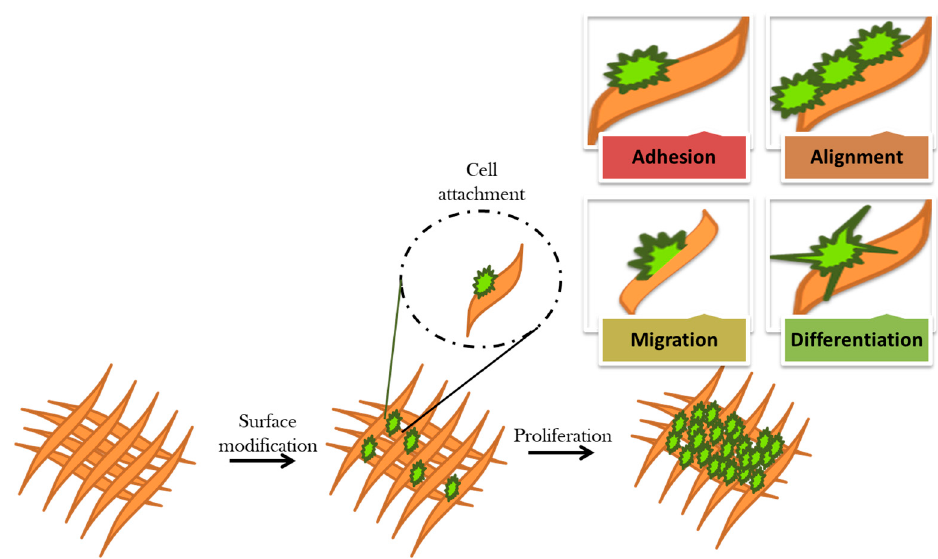
Figure 6. Schematic representation of cellular responses of surface modified biomaterial.